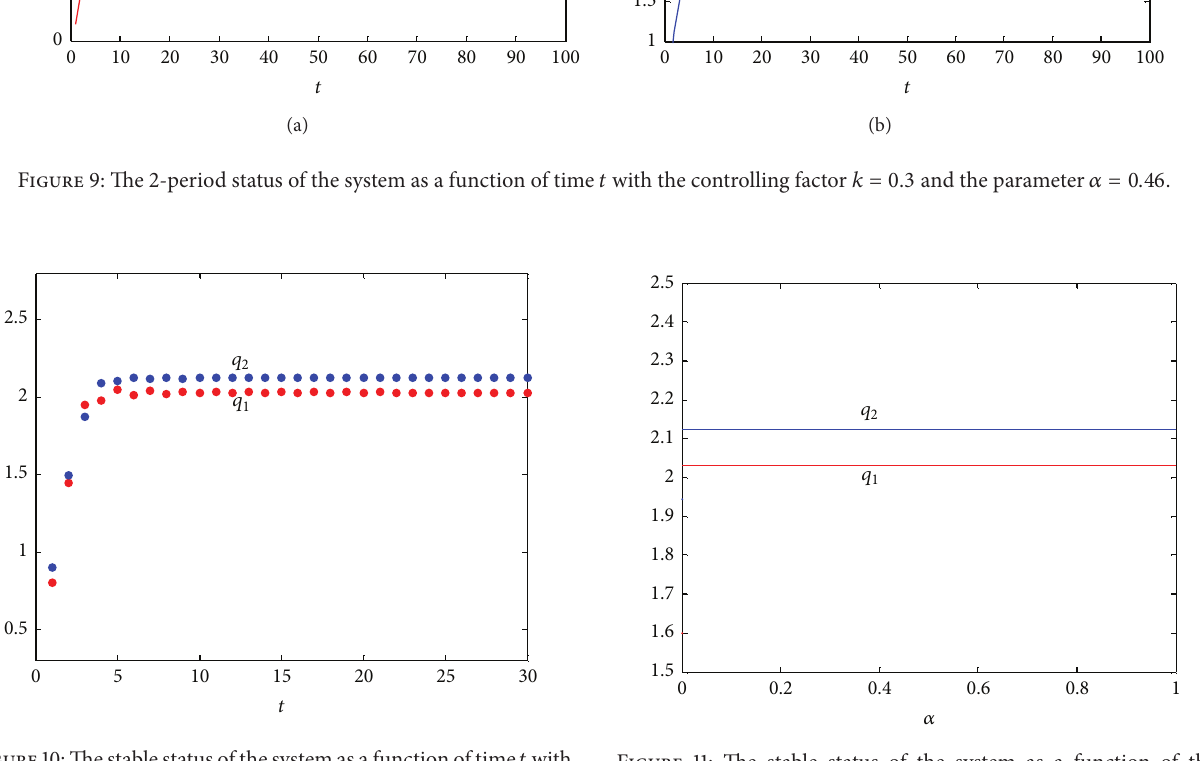
with the original system, which delays or prevents the appearance of chaos.